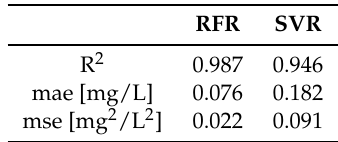
Table 5. Nearshore oxygen prediction error